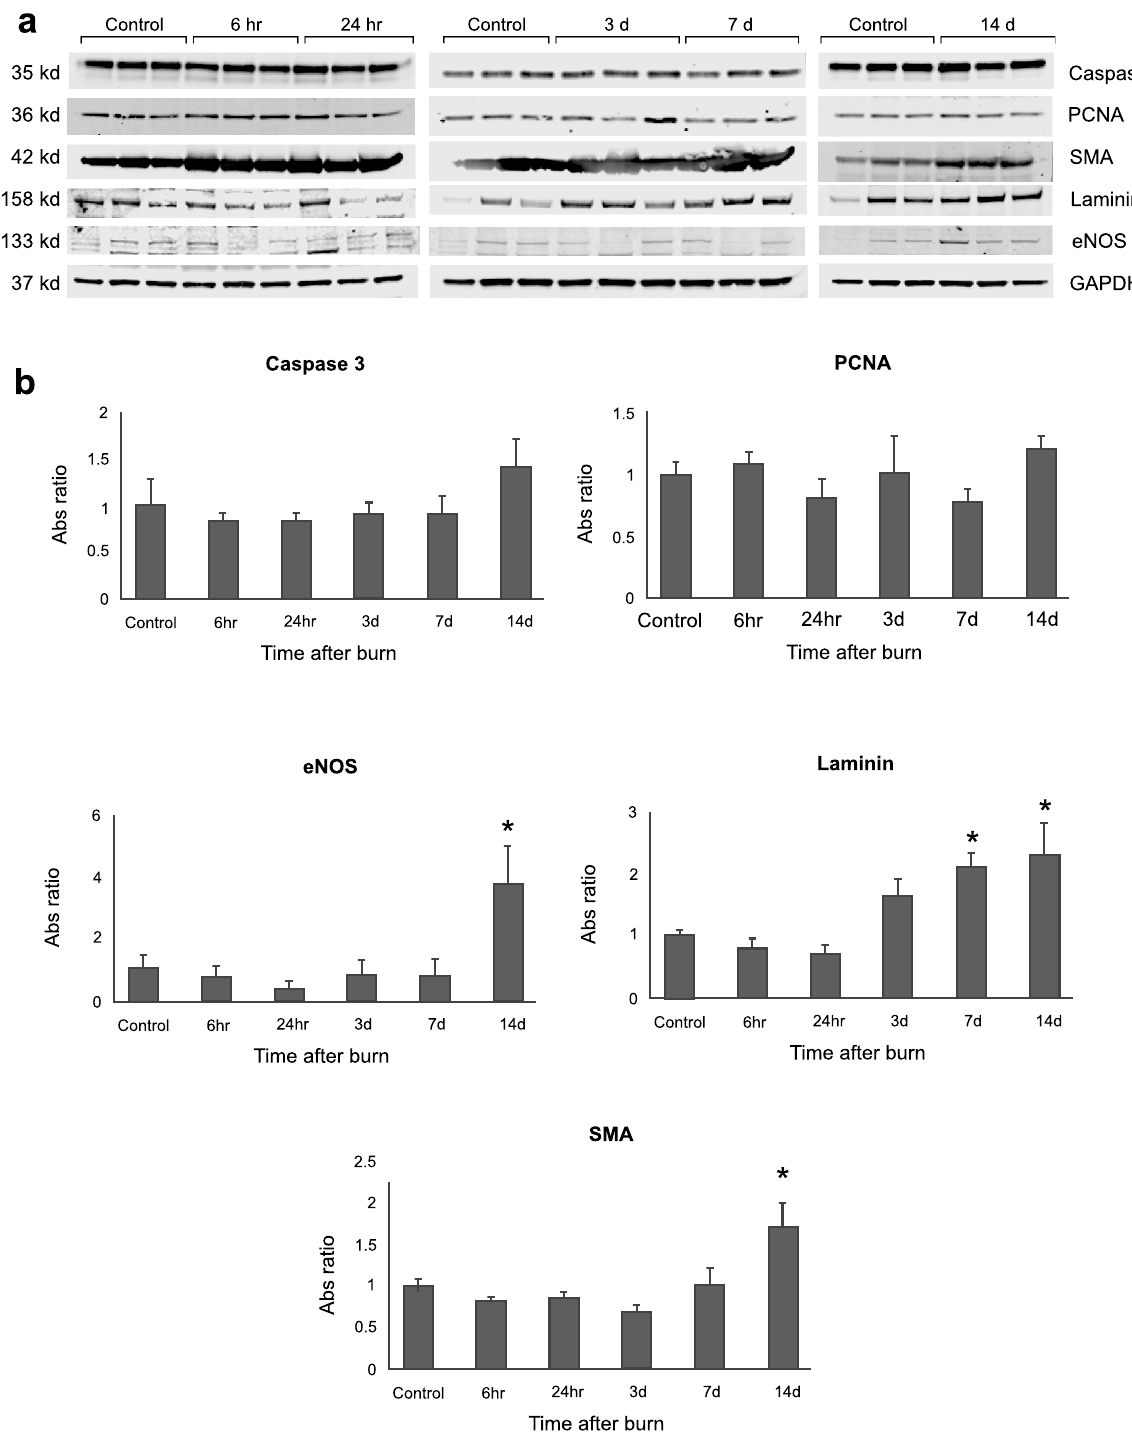
Figure 5. ( a ) Western blot images, and ( b ) Statistical analysis of signals caspase 3, PCNA, eNOS, Laminin, and α-SMA. The absorbance intensity was normalized with internal control GAPDH. *, p < 0.05, versus control group, one-way ANOVA with Dunnett’s method was applied. Data were presented as mean ±